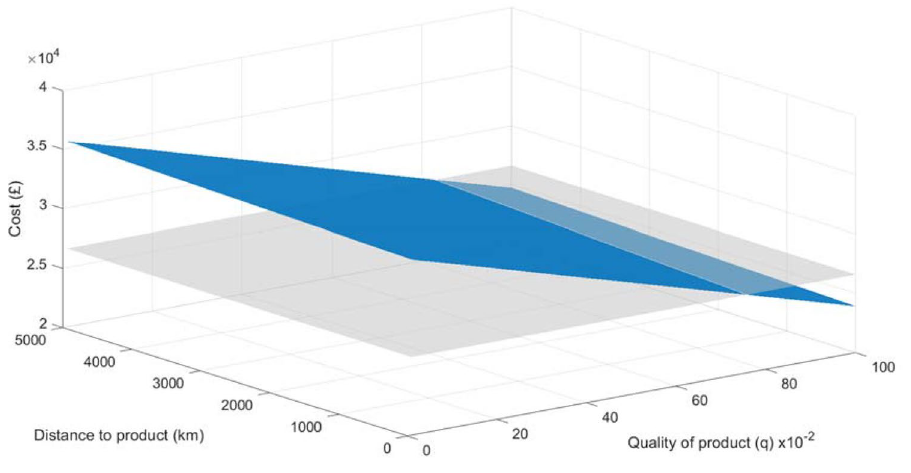
Figure 5. Results of